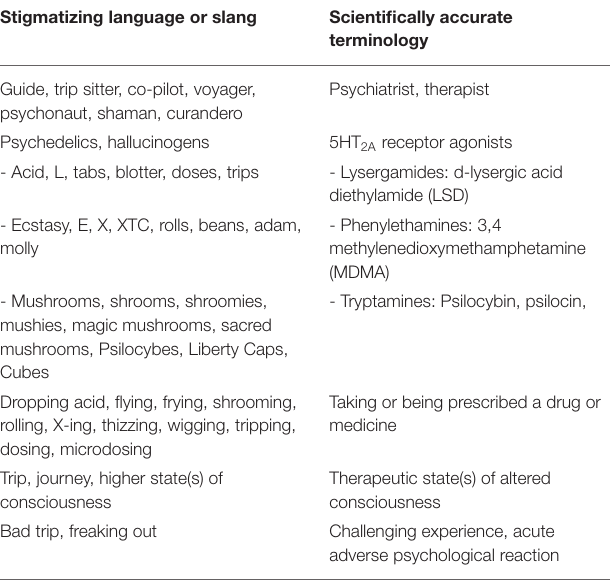
TABLE 1 | Recommendations for clinically accurate